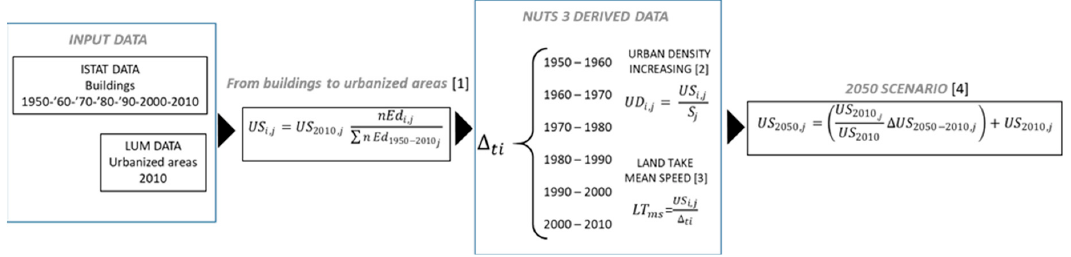
Figure 2. Methodological flow chart.